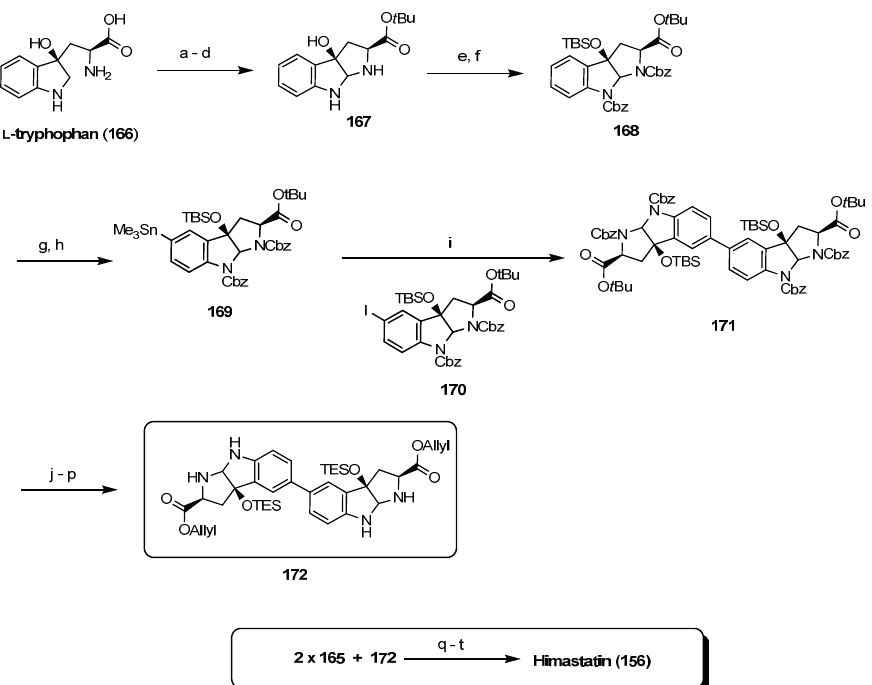
Scheme 9. Total synthesis of himastatin 156 : final